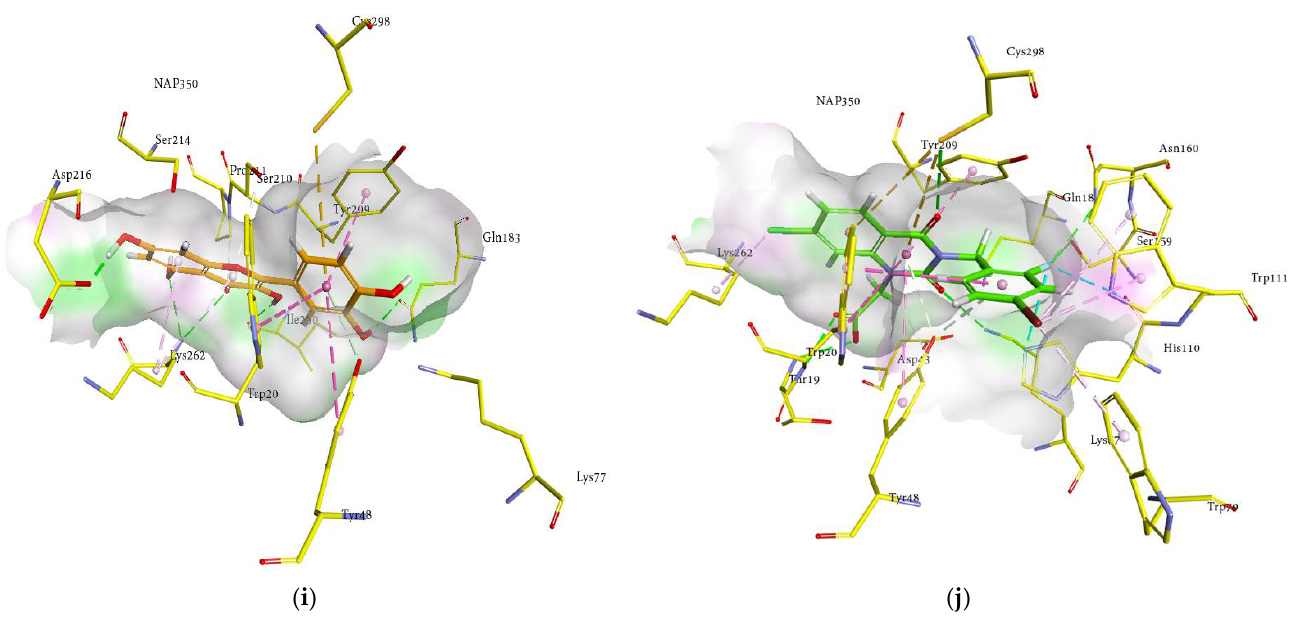
Figure 5. Molecular docking models for HRAR inhibition by ginsenosides and diagrams of ligand 3D interactions and the major binding sites of the eight ginsenosides in the HRAR active site; protopanaxadiol ( a ), (20 S ) ginsenoside Rg3 ( b ), (20 R ) ginsenoside Rg3 ( c ), ginsenoside Rh2 ( d ), compound K ( e ), protopanaxatriol ( f ), (20 R ) ginsenoside Rg2 ( g ), ginsenoside Rh1 ( h ), quercetin ( i ), and zenaresta ( j ). The interactions are shown by green (conventional hydrogen bonding), yellow (π- sulfur interactions), tea pink (π-π T shaped and π-π stacked interactions), cyan (fluorine), and yellow (π-sulfur).